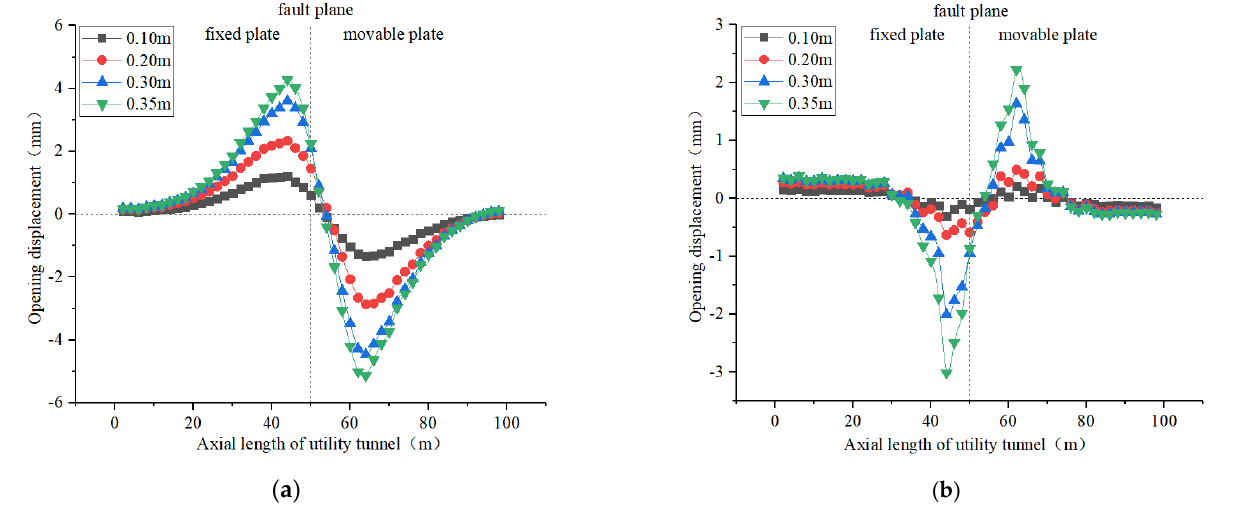
Figure 8. Distribution curves of the longitudinal horizontal opening displacement. ( a ) Roof ( b ) Floor.